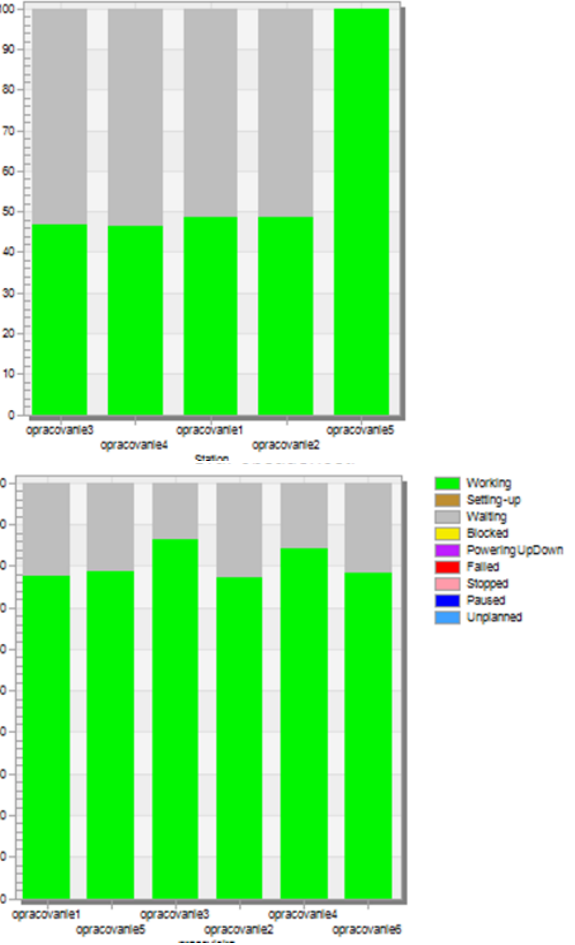
Figure 8: Graph of the utilization of EOL before the change and after the change